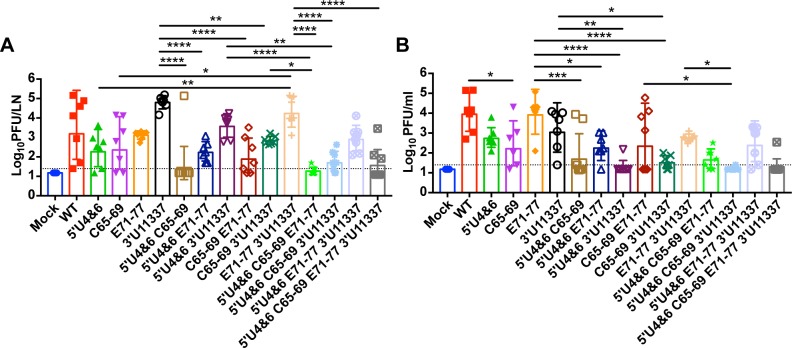
LAV replication in popliteal lymph nodes (PLN) and serum.CD-1 mice were infected with equal genomes of the LAV candidates corresponding to 103 pfu of WT EEEV (WT). At 24hpi, single PLN (A) or serum (B) were harvested and a plaque assay was performed. Each point represents an individual mouse. n = 6–8 mice, 2 independent experiments. Data is log10 transformed and the geometric mean (bar) with geometric mean standard deviation graphed and compared between groups. Single mutant LAVs were compared to WT, double mutant LAVs were compared to single mutant LAVs, triple mutant LAVs were compared to the double mutant LAVs, and the quadruple mutant LAV was compared to the triple mutant LAVs. Only comparisons that were significant are represented, all other comparisons were non-significant. *p<0.05, **p<0.01, ***p<0.001, ****p<0.0001 by one-way analysis of variance with Tukey’s multiple-comparison test of log-transformed data.